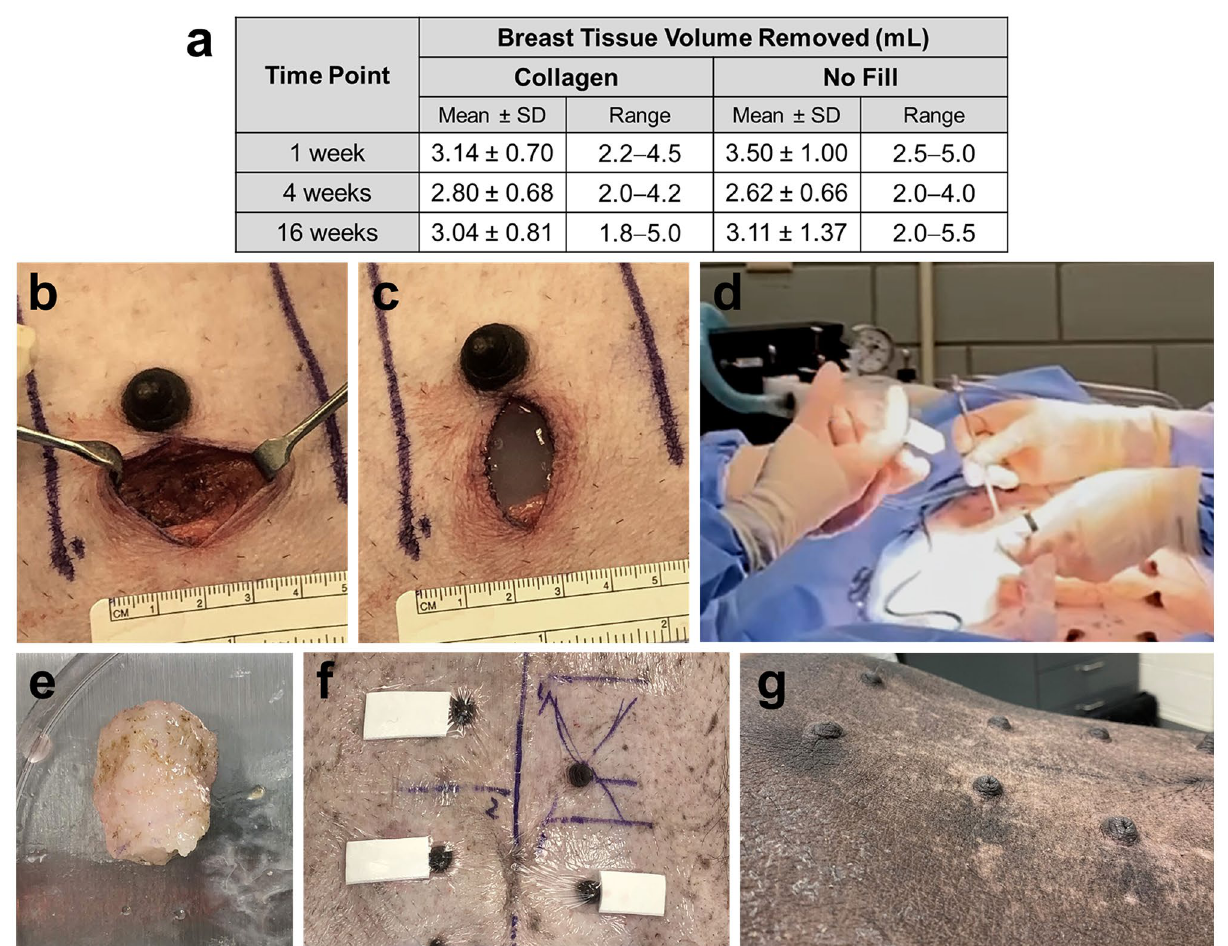
Figure 2. Overview of simulated lumpectomy procedure. ( a ) Table summarizing surgically excised mammary tissue volume, which represented roughly one-fourth total breast tissue volume. Data (mean ± SD) compiled from both longitudinal and radiation studies (1 week: collagen filler: n = 12, no fill = 6; 4 weeks: collagen filler: n = 18, no fill: n = 9; 16 weeks: collagen filler: n = 18, no fill: n = 9). Surgical void ( b ) before and ( c ) after filling with collagen. ( d ) Application of scaffold-forming collagen. ( e ) Excised mammary tissue. Surgical sites ( f ) immediately following surgery showing bandaging and ( g ) 16 weeks following simulated lumpectomy with